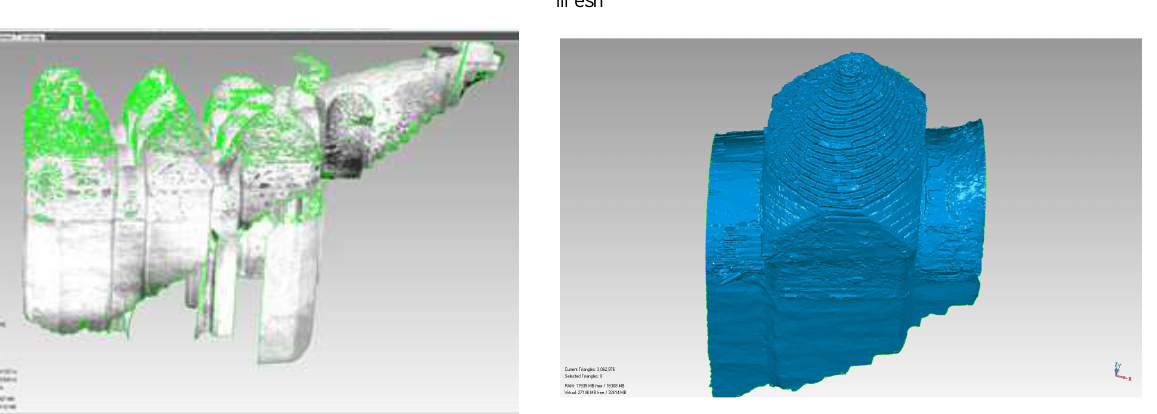
Figure 8-b. Medium mesh models from 50% filtered point cloud